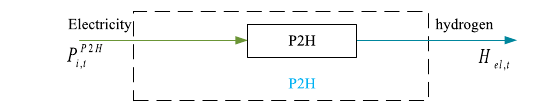
FIGURE 3 | Structure of